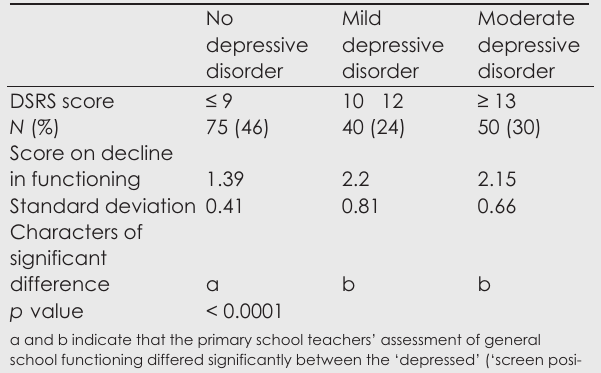
Table I. Kruskal-Wallis one-way ANOVA comparing the decline in general school functioning as observed by teachers, with the defined depressive disorder categories on the self-report scale (‘screen positives’ and ‘screen